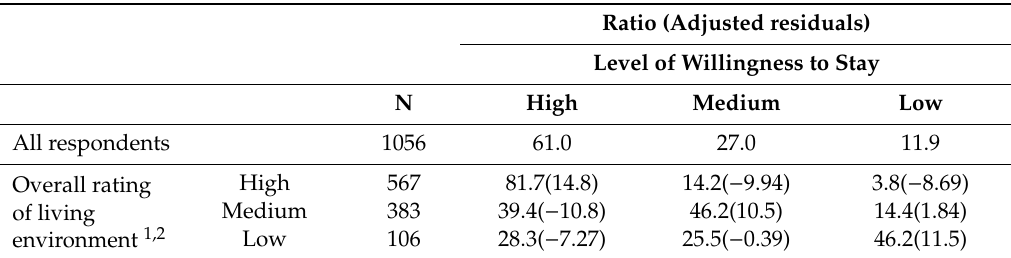
Table 4. Willingness to remain at the current residence determined by the evaluation of the living environment at current place of